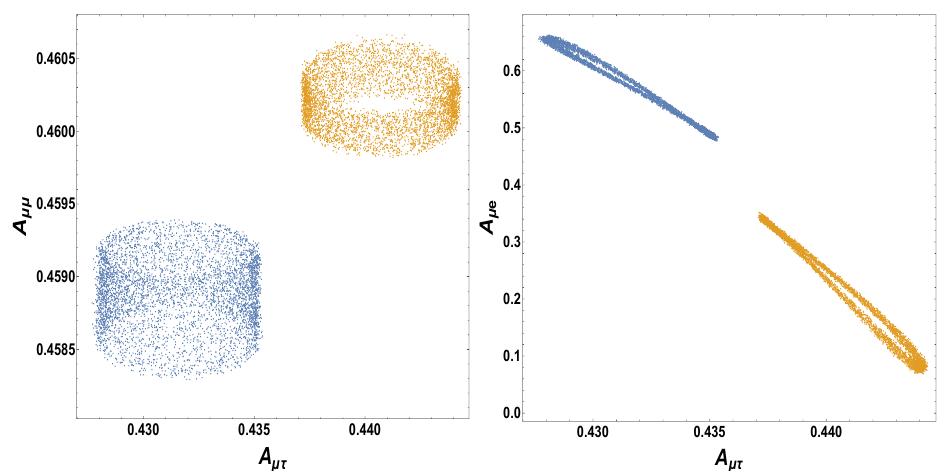
Figure 6. Same as Figure 5 but with the optimized flux. Notice the different vertical scales on the left and right